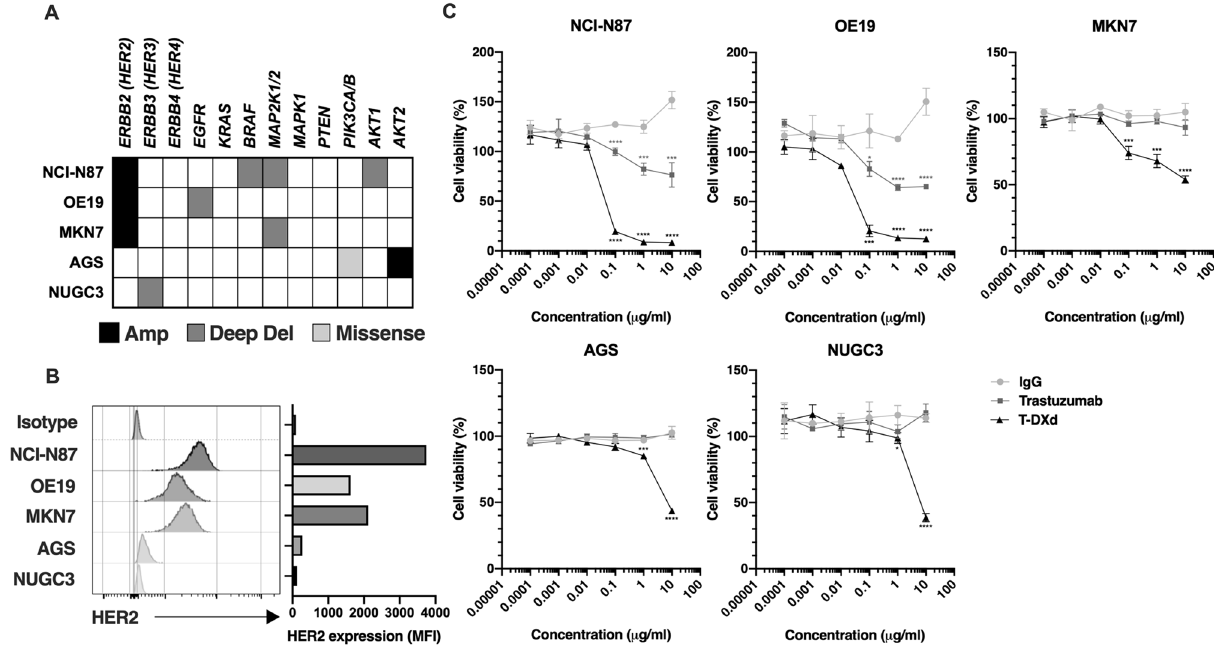
Figure 1. The effect of T-DXd on HER2-positive and HER2-negative GC cells. ( A ) Genetic alterations and mutations of the ErbB (HER) family and its downstream molecules in indicated GC cell lines. Black: amplification, gray: deep deletion, light gray: missense mutation, white: no alteration and no mutation. ( B ) HER2 expression on HER2-positive and HER2-negative GC cell lines. ( C ) Cell viability assay in HER2-positive and HER2-negative GC cell lines treated with several concentrations of human IgG isotype control, trastuzumab, or T-DXd for 6 days (n = 3). Values are shown as means ± SEM. * P < 0.05, *** P < 0.001, **** P <